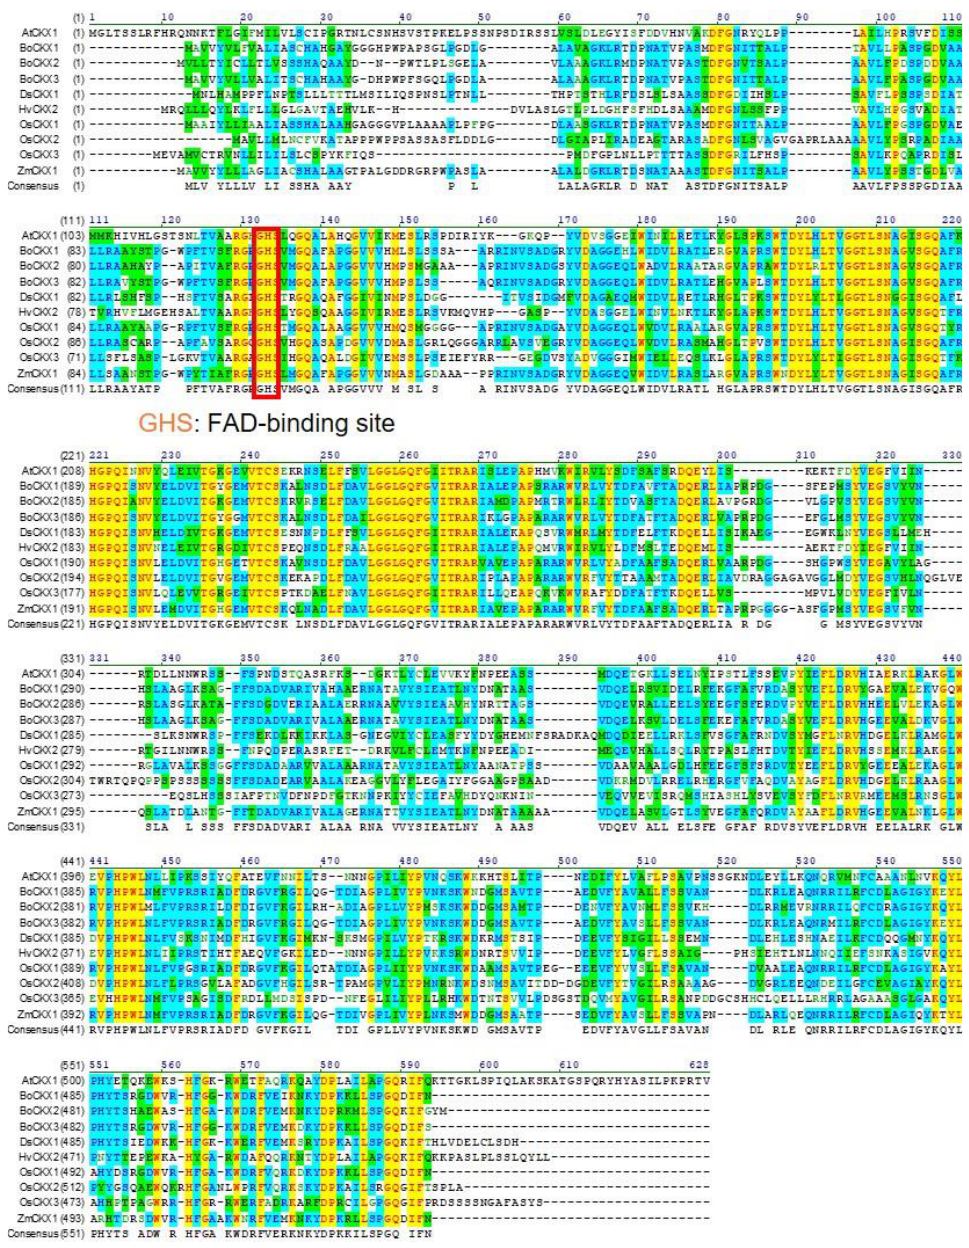
Figure 3. Sequence alignment of the primary structure of BoCKX proteins with CKXs proteins from other species. The sequences shown here were from Arabidopsis thaliana (AtCKX1), Bambusa oldhamii (BoCKX1–3), Dendrobium sonia (DsCKX1), Hordeum vulgare (HvCKX2), Oryza sativa (OsCKX1–3), and Zea mays (ZmCKX1). The conserved FAD-binding site, GHS motif, was indicated.